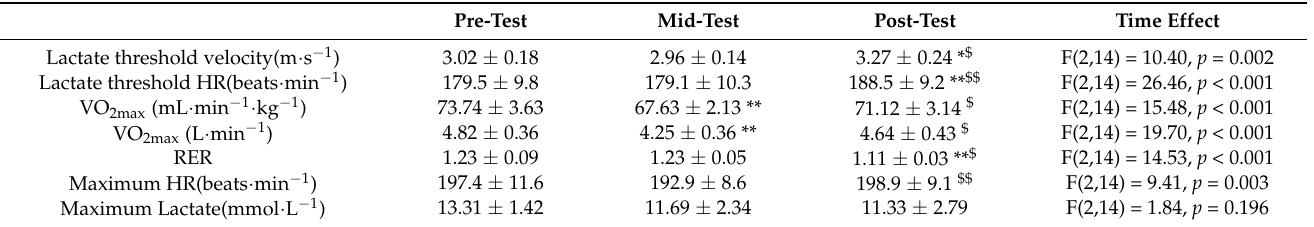
Table 3. Changes in Lactate Threshold and Maximum Oxygen Uptake after 4 weeks Moderate Altitude Training.